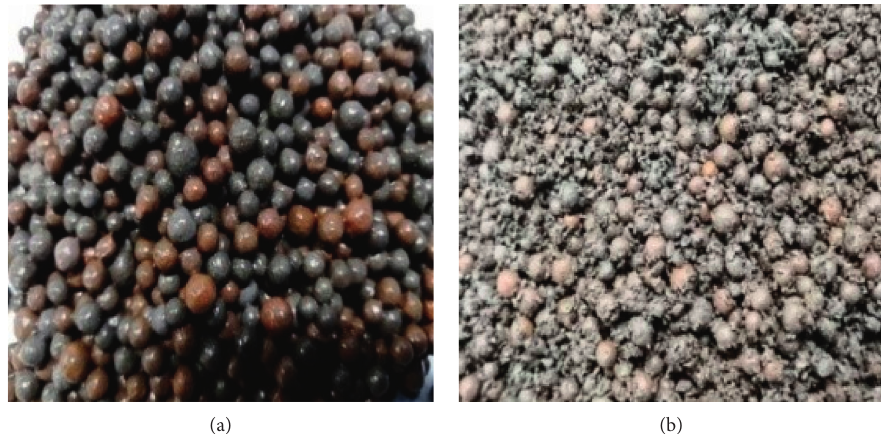
Figure 7: Coal gangue ceramsite under freeze-thaw cycles. (a) Unfrozen coal gangue ceramsite. (b) Coal gangue ceramsite under 50 cycle